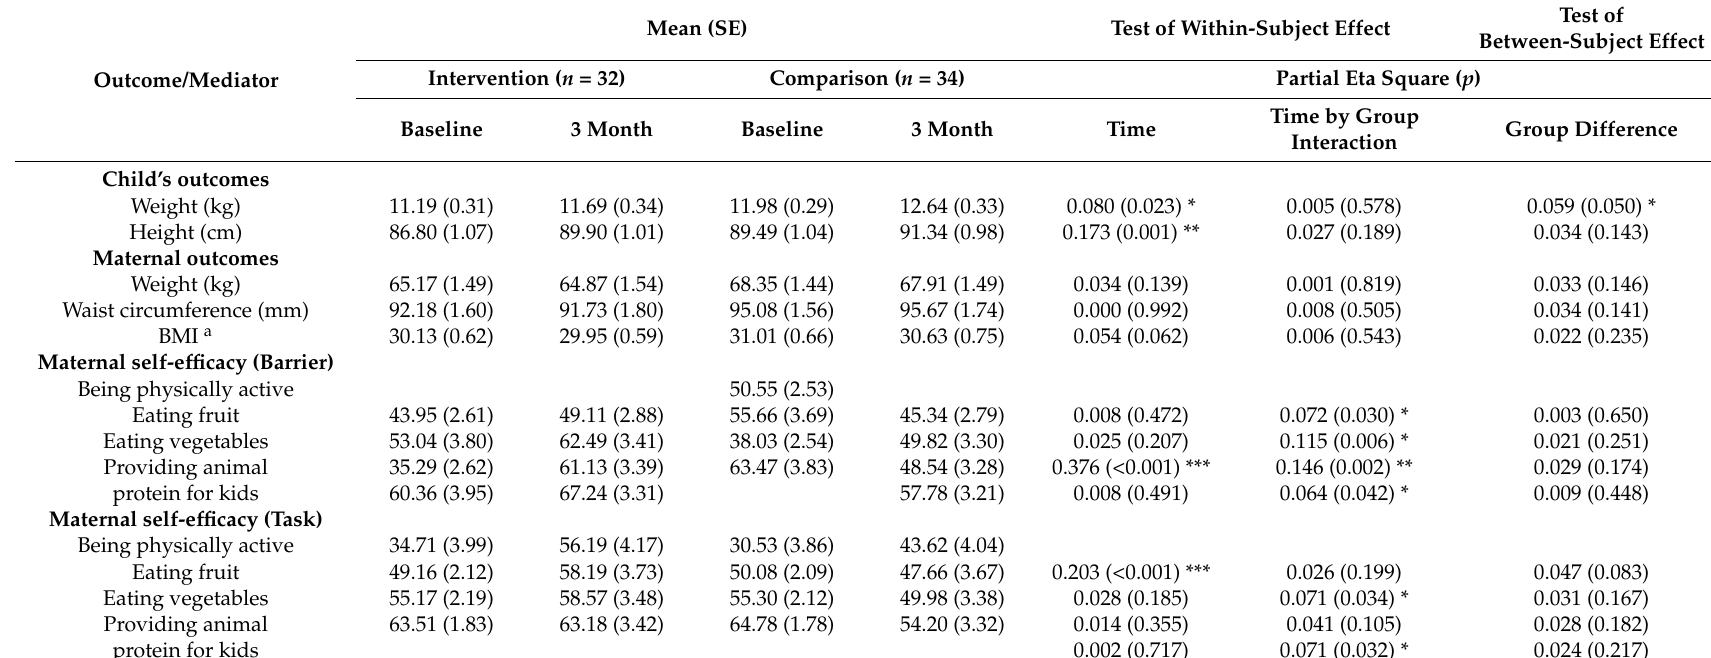
Table 3. Group means and test of within- and between- subject effect ( n =